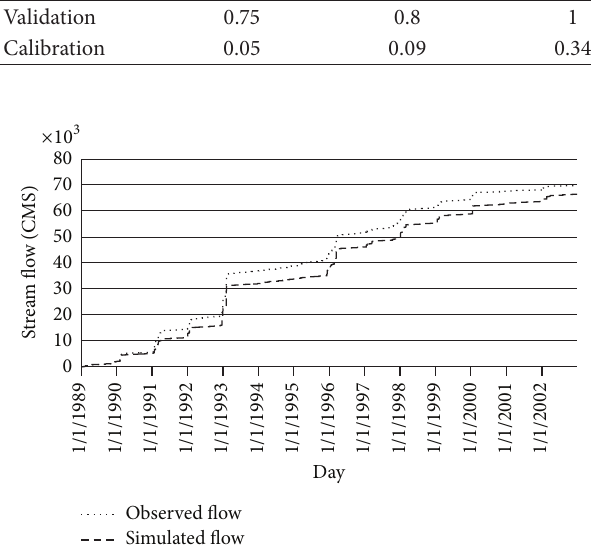
Figure 6: Cumulative daily stream flow m 3 /s (CMS) for calibration period.